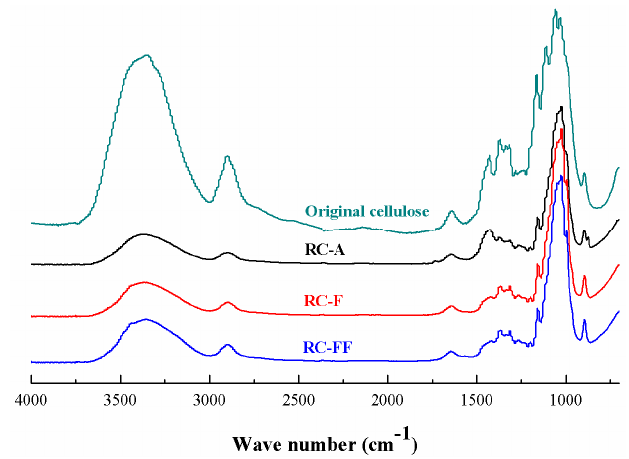
Figure 4. Fourier transform infrared spectroscopy (FT-IR) spectra of of RC-A, RC-F, and RC-FF, and the original cellulose.